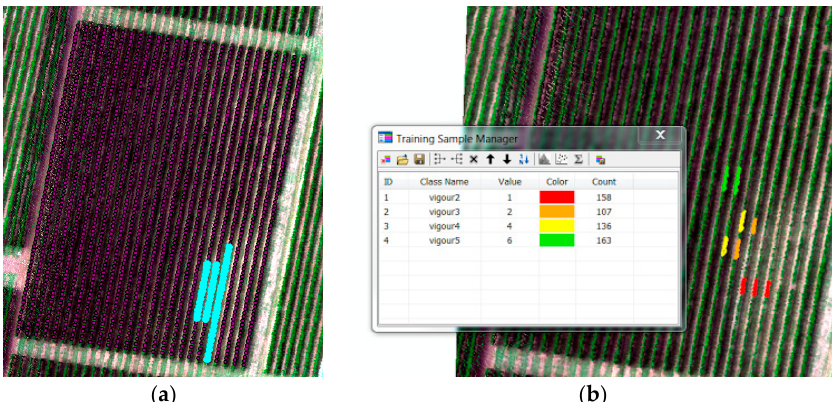
Figure 4. Selection of individual plants or grapevines for spectral signature extraction based on vigour assessment into four classes. ( a ) Selected grapevines from an attribute table where vigour is 2/5 ( b ) Four different polygon areas for each class based on grapevine location and vigour assessment.